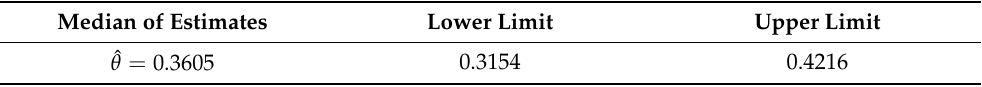
Figure 6a,b represent the empirical TTT plot and histogram of the secondary reactor pumps data. A bathtub hrf is indicated by the TTT plot for the secondary reactor pumps data. From the histogram, it can be seen that the empirical line is closer to the fitted line of the UTD model than other models. The estimated variance of the MLE ˆ θ of the UTD parameter θ for the times between failures of secondary reactor pumps data data is calculated by J − 1 ( ˆ θ ) = 0.0008 Therefore, an approximate 95% confidence interval for θ is given by [ 0.3057, 0.4193 ] . Table 13 provides the median of bootstrap estimates and bootstrap confidence intervals. Table 13. The median of bootstrap estimators and bootstrap confidence